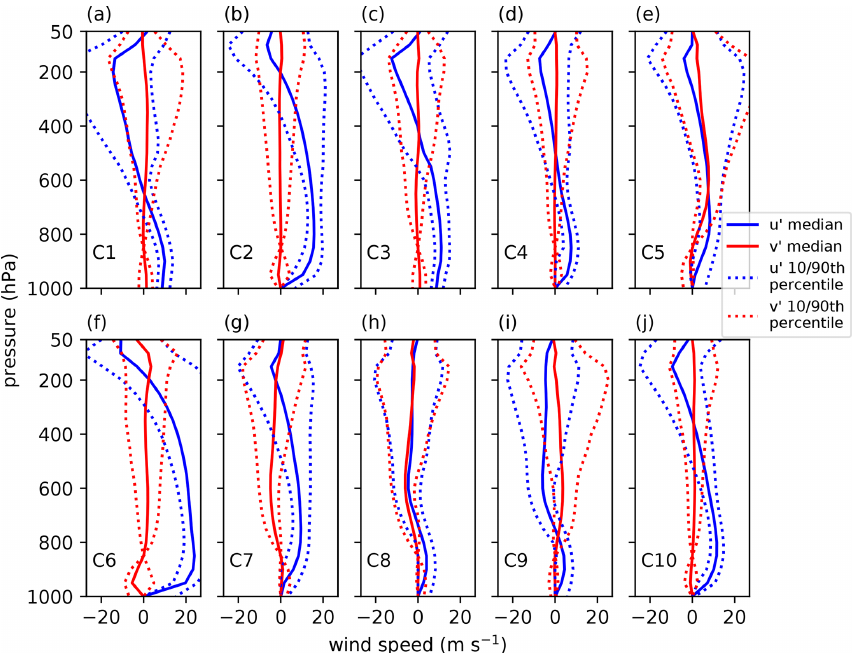
Figure 4. u (cid:48) and v (cid:48) wind profiles of the median of the 10 RWP clusters, with (a) showing cluster 1 (C1), (b) showing cluster 2 (C2) and so on. They have been denormalized with respect to magnitude. The 10th and 90th percentiles are also shown.